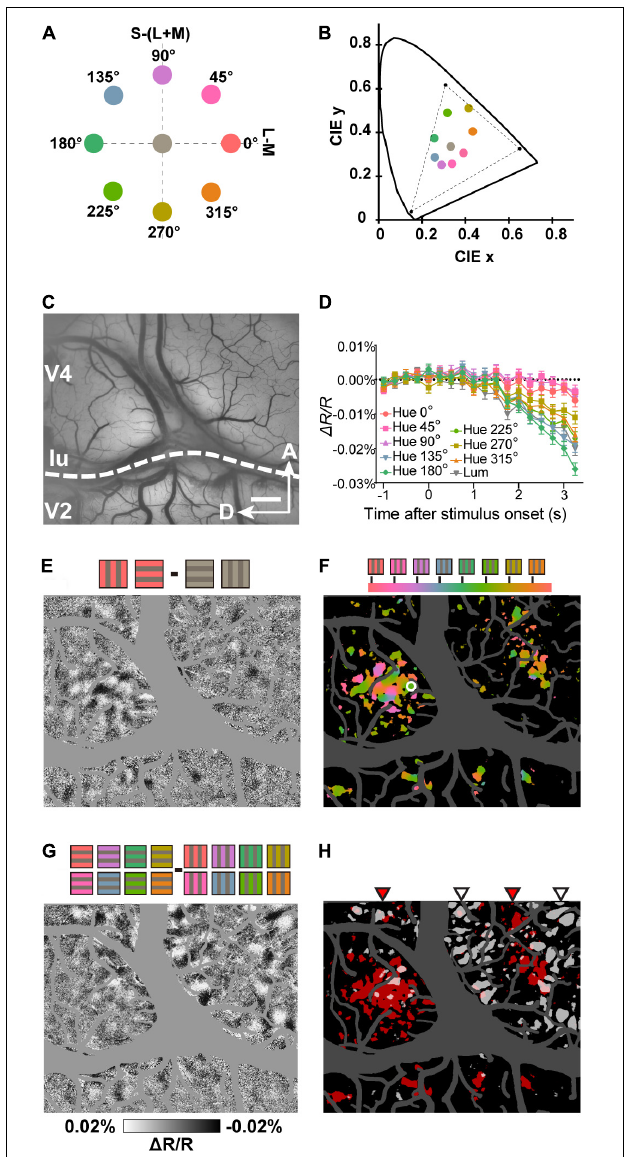
FIGURE 1 | Imaging hue preference maps in visual cortex. (A) Location of the hues and gray used in the stimuli in the equiluminant plane of the DKL color space. (B) The same hues and gray in the CIE 1931 xyY chromaticity space. The dashed triangle indicates the gamut of the LCD monitor used for stimulation. (C) Example of an imaged region containing V2 and V4. (D) Time courses of average reflectance change at a sampled site (white circle in F ) in response to the grating stimulus with each of the eight hues and one gray. Error bars represent standard error of the mean (SEM). (E) A subtraction map in response to Hue 0 ◦ minus achromatic grating stimuli ( n = 160 presentations). Note that in the subtraction map, darker pixels indicate a stronger response for the first condition and lighter pixels for the second condition (F) A color-coded vector map of hue preference. Hue preference indicated by colors according to the key at the top. Colored regions represent pixels that had a strong selectivity for hues (one-way ANOVA, n = 640 presentations, P < 0.0001, uncorrected). (G) A subtraction map in response to horizontal minus vertical grating stimuli of eight hues. (H) Statistical maps created using two-way ANOVAs with hue (eight hues) and orientation (Continued)